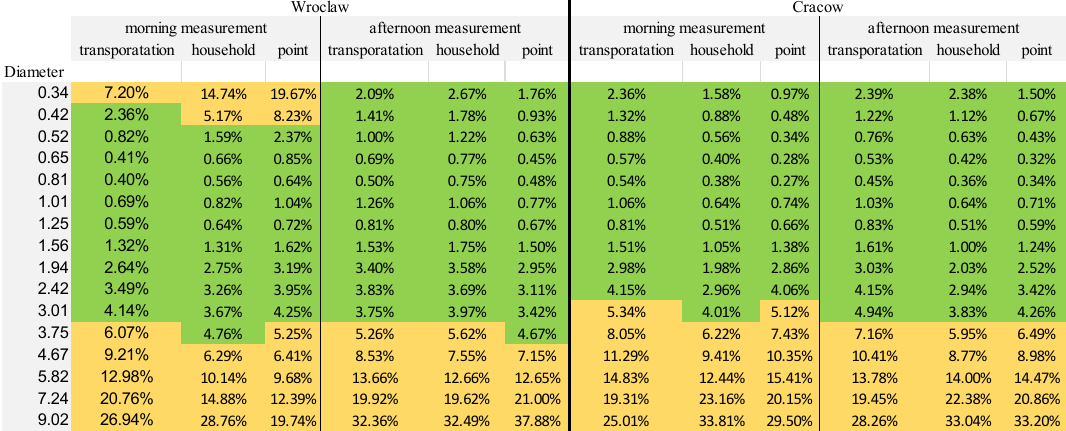
Figure 4. Percentage of particulate matter by their size in tests (all sectors).